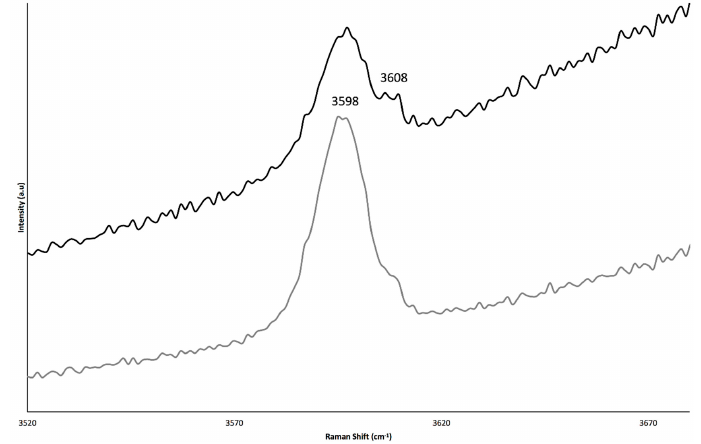
Figure 24. Raman spectra from 3520 to 3680 cm − 1 of an emerald from Zambia. The black and grey spectra are acquired with the laser beam perpendicular to the c-axis and parallel to the c-axis, respectively. Note that the upper spectrum is shifted higher for clarity.